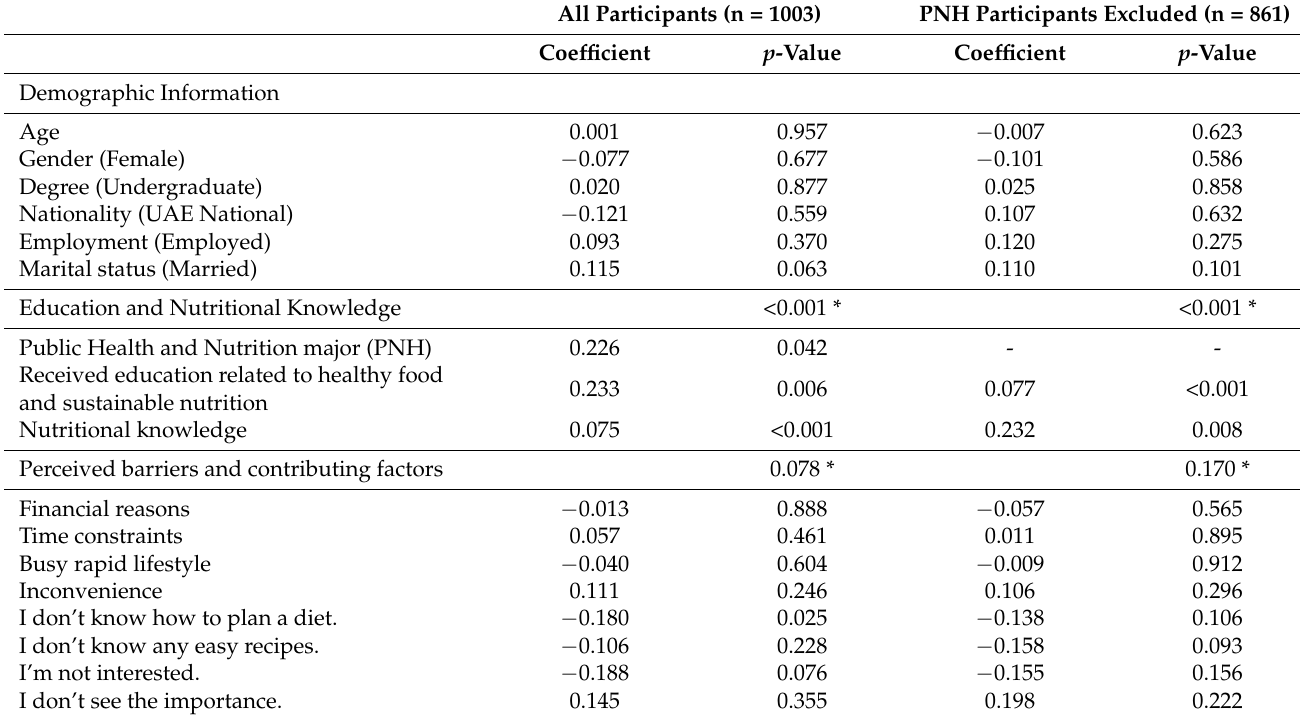
Table 4. Multiple regression models to identify the determinants of healthy habits.